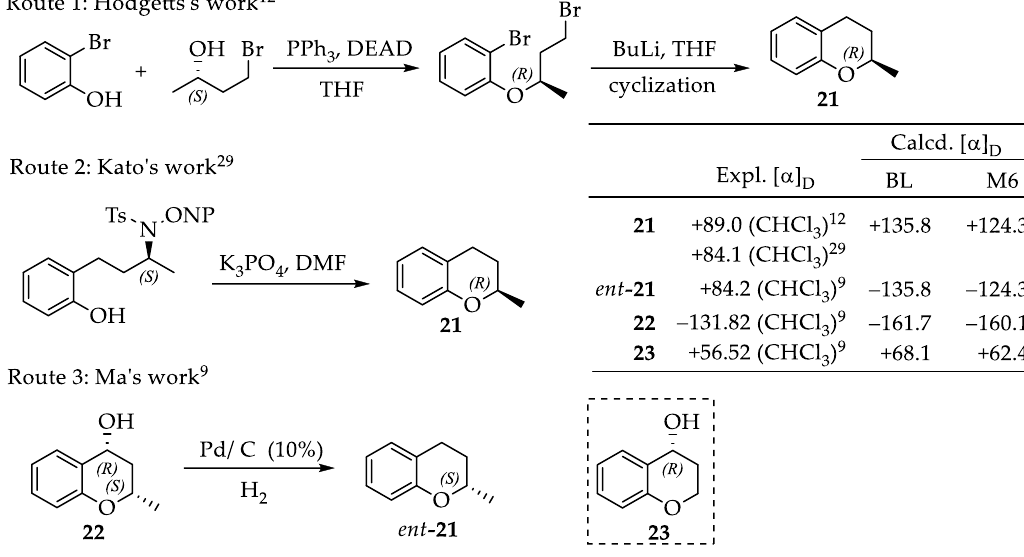
Figure 3. Experimental and calculated SORs for typical 2-substituted chromanes. BL: BL: PCM/B3LYP/Aug-cc-pVDZ//B3LYP/6-311G(d,p), M6: PCM/M06-2X/Aug-cc-pVDZ//M06- PCM/B3LYP/Aug-cc-pVDZ//B3LYP/6-311G(d,p), M6: PCM/M06-2X/Aug-cc-pVDZ//M06-2X/TZVP. Experimental SOR data were collected from references [12,38 – 50].